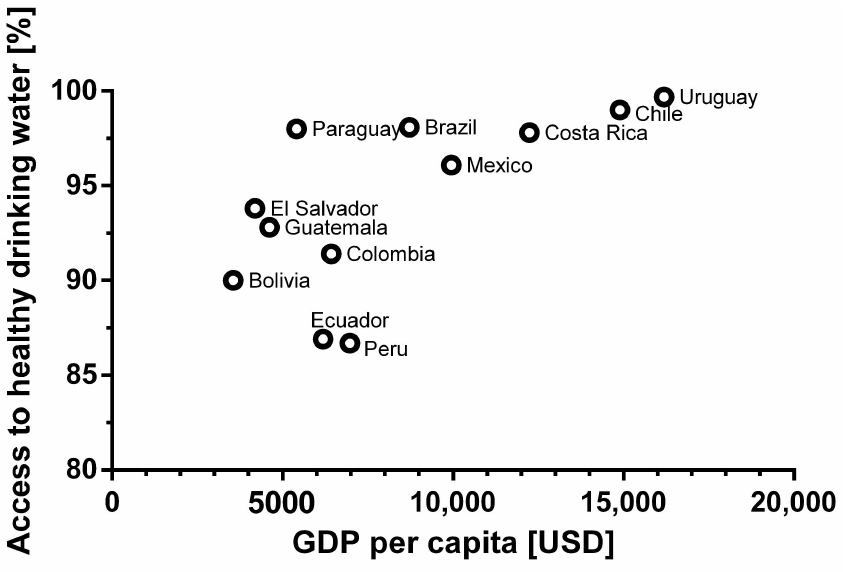
Figure 5. Access to healthy drinking water versus Gross Domestic Product (GDP) per capita in some countries of Latin America and the Caribbean. Source: GDP values were taken from The World Bank (2019) and the water access data were taken from the Aquastat database.